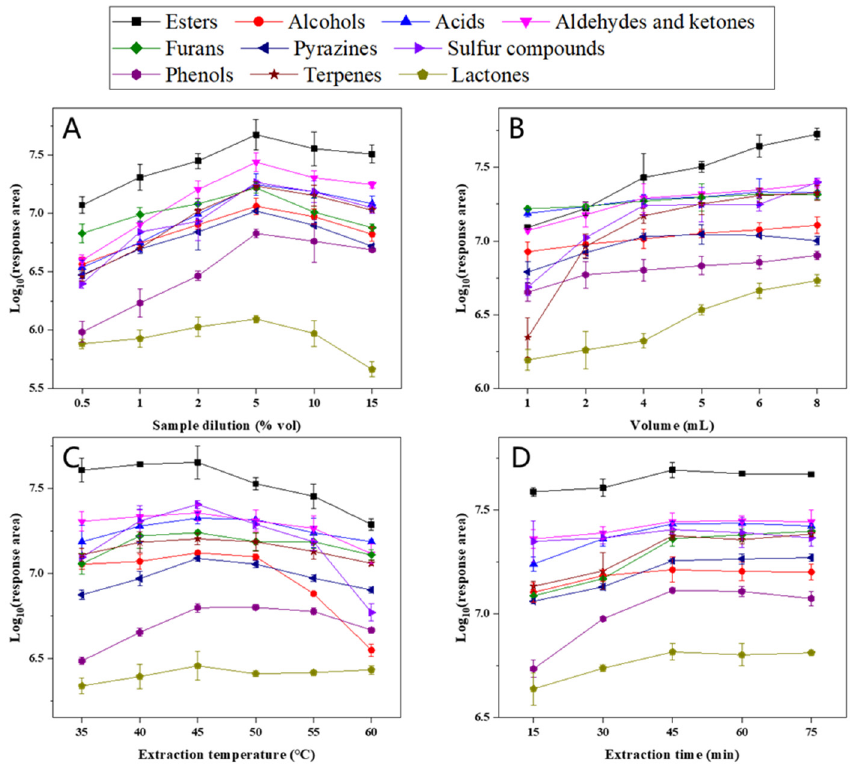
Figure 3. Effects of parameters on the 10 different chemical classes of compounds’ peak area: ( A ) sample dilution, ( B ) liquid volume, ( C ) extraction temperature, and ( D ) extraction time.